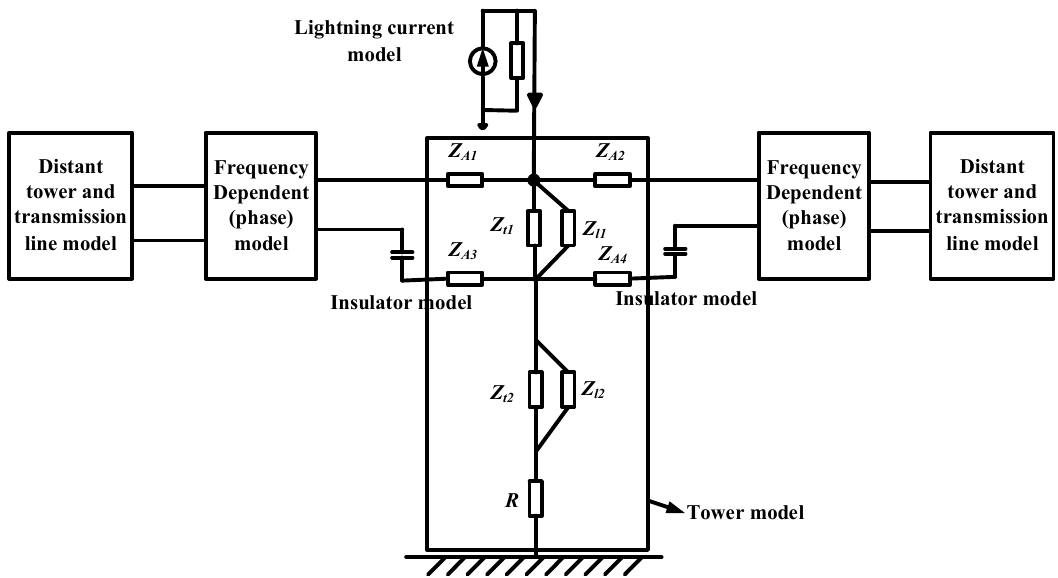
Figure 7. Simulation model for this